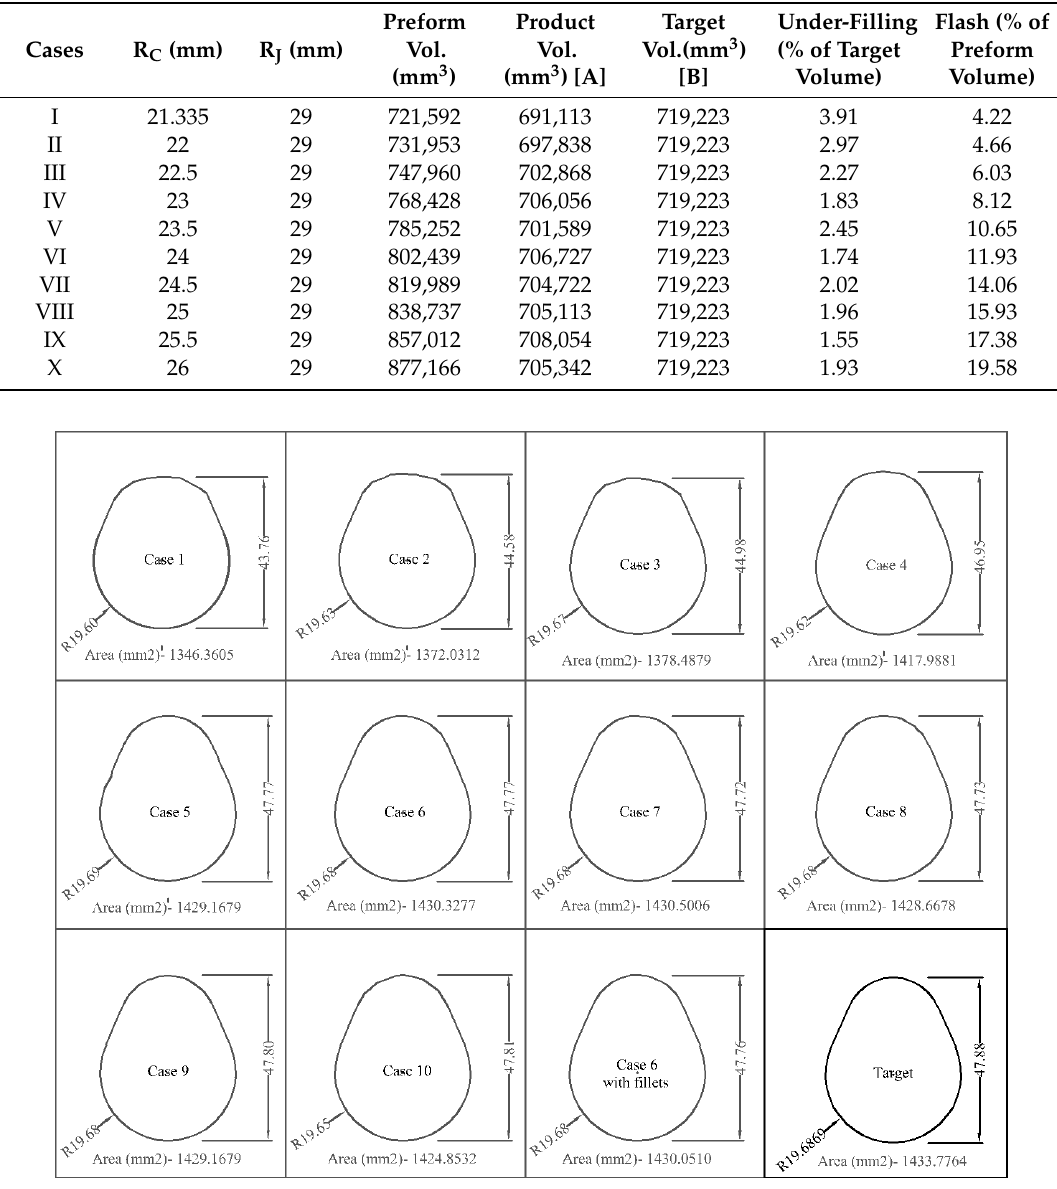
Table 4. Volumetric Analysis of Preform Geometry. Table 5. Percentage of Deviation from Targeted Area.